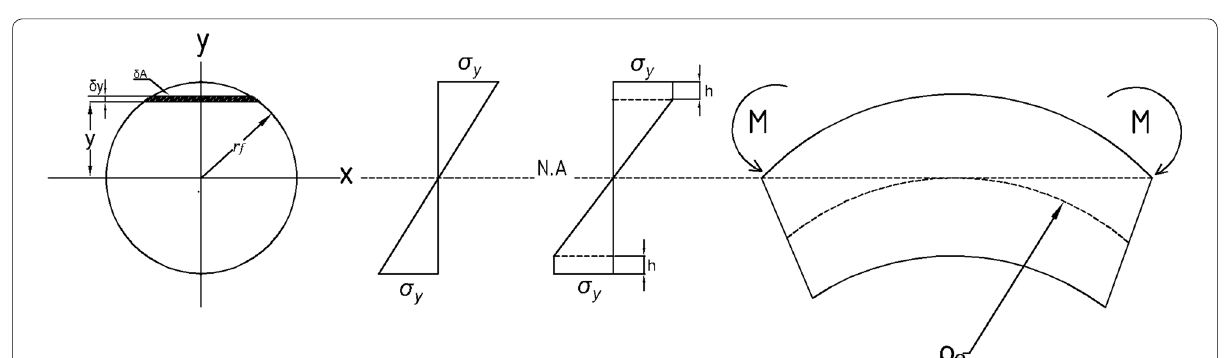
Fig. 11 Stress distribution of the steel fibre circular section.